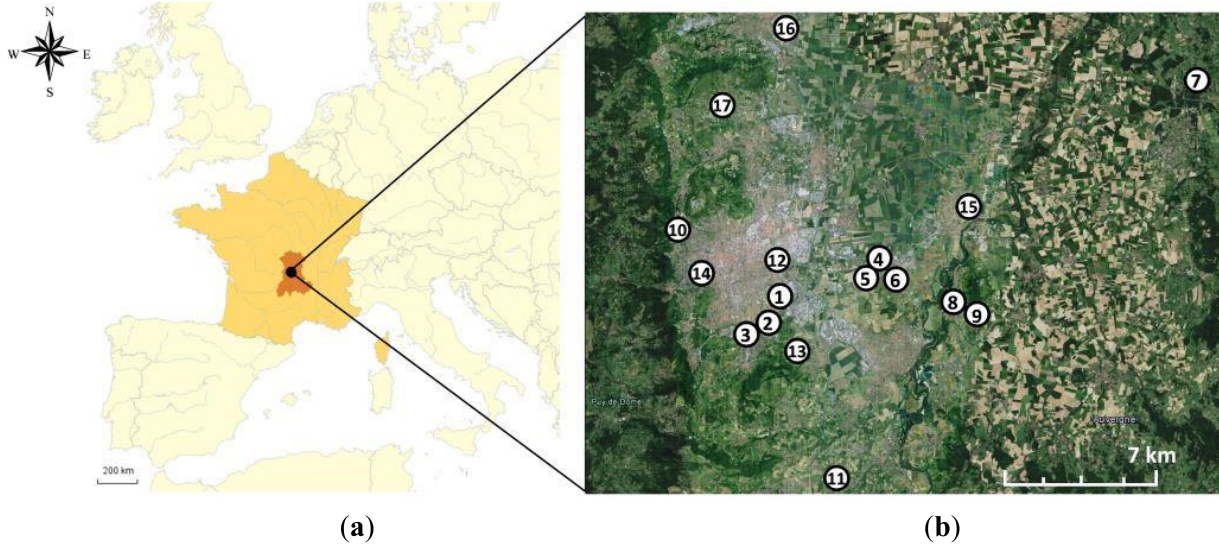
Figure 1. Location of the study area in the Auvergne region (dark orange) of central France ( a ), and the locations of the 17 schools in the Clermont-Ferrand area ( b